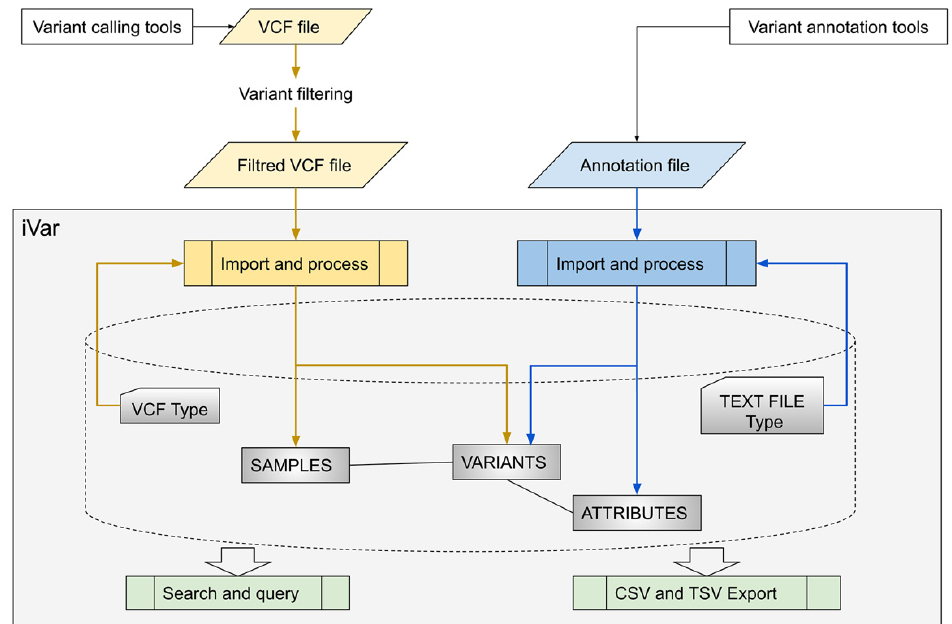
Figure 1. Overview of iVar, a platform for the unified management of variants identified by different sequencing technologies. CSV Comma Separated Value; TSV Tab Separated Value; VCF Variant Call Format.